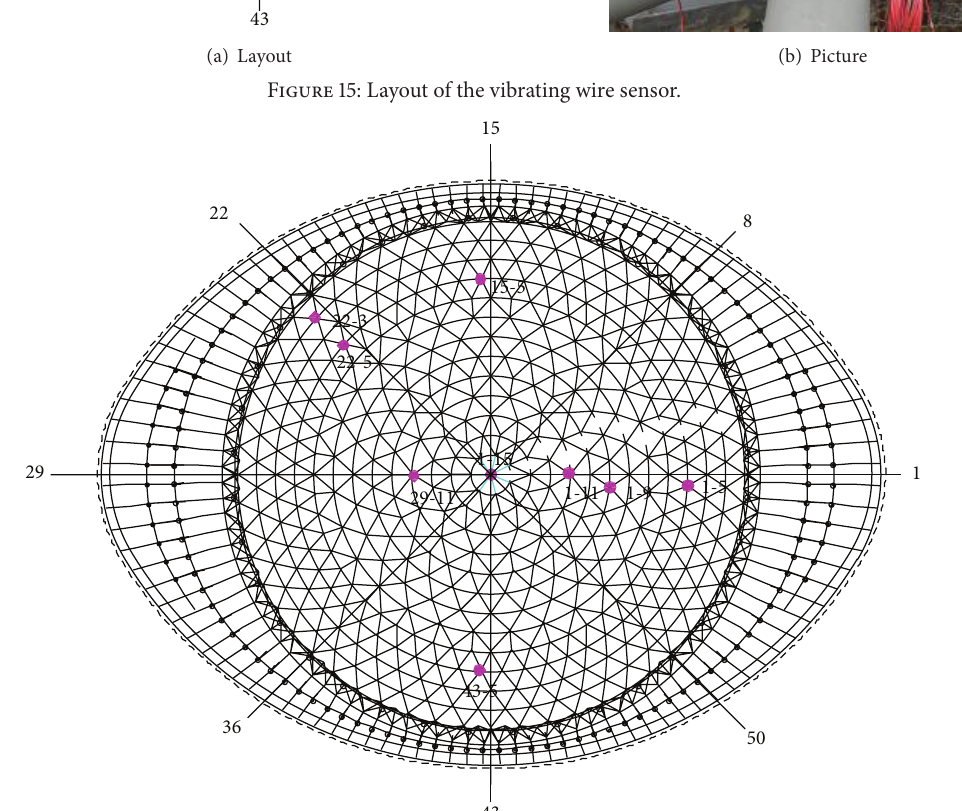
Figure 16: Layout of the vertical displacement measuring